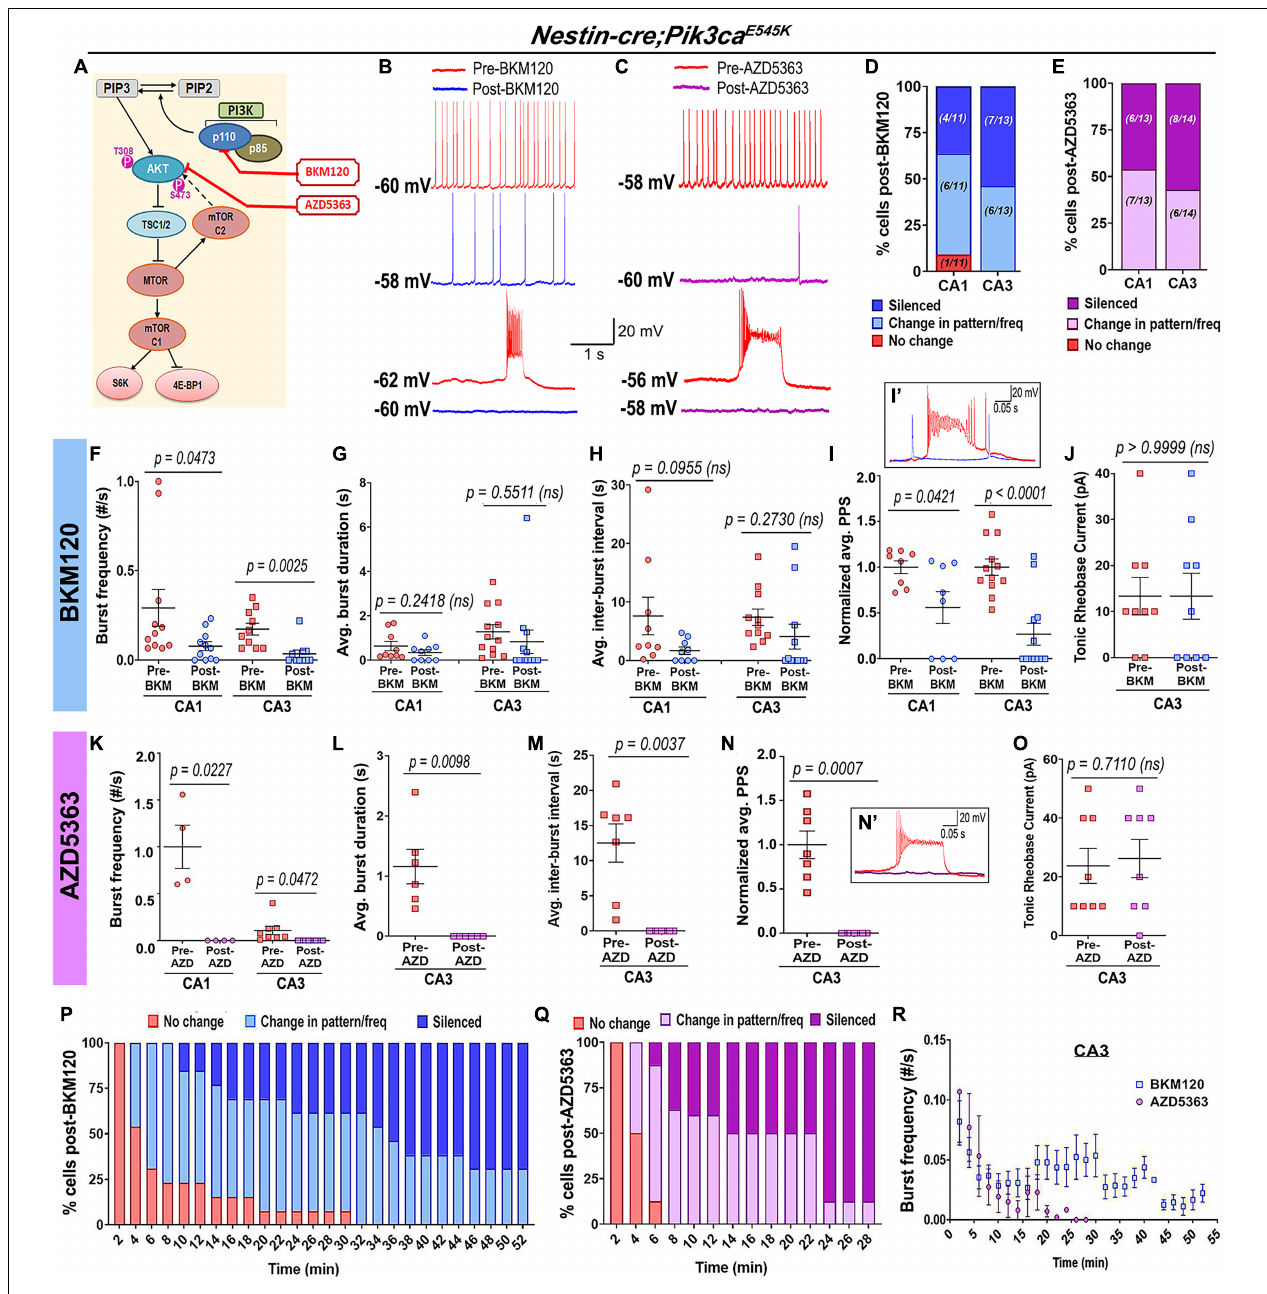
FIGURE 6 | Acute inhibition of Pik3ca or AKT suppresses hyperactivity in mutant neurons. (A) Schematic of simplified PI3K-AKT-MTOR pathway, marking targets of action for BKM120, AZD5363, and RAD001. Representative traces demonstrate differential action of BKM120 (B) and AZD5363 (C) on Nestin-cre;Pik3ca E 545 K hippocampal neurons, ranging from being unaffected to change in frequency/pattern to silencing, as quantitated, respectively, in panels (D,E) . (F–J) Acute BKM120 treatment in the mutant neurons significantly reduced burst frequency ( F = 8.937, df = 38) and PPS ( F = 24.39, df = 36) in both CA1 and CA3; but did not significantly affect the average burst duration ( t = 1.073, df = 4), inter-burst interval ( t = 0.4023, df = 4) or rheobase current ( t = 1.000, df = 4). (K–O) Acute AKT inhibition in mutant slices by AZD5363 significantly reduced burst frequency ( F = 43.50, df = 20), PPS ( t = 6.386, df = 6), average burst duration ( t = 4.052, df = 5) and inter-burst interval ( t = 4.597, df = 6), largely by suppressing bursts or silencing the cells. AZD5363 had no effect on the mutant rheobase current ( t = 0.3859, df = 7). (I’,N’) Insets show activity traces of mutant bursting cell before (red) and after BKM120 (blue) or AZD5363 (pink) administration. Plots marked percentage of mutant CA3 “bursting” cells undergoing changes as a function of time, in response to acute administration of BKM120 (P) and AZD5363 (Q) . (R) Mutant plateau frequency significantly dropped as a function of time, where 0 min marked the time of administration of BKM120/AZD5363 onto the brain slice. Data is represented as % bar graphs and mean ± SEM scatter plots; differences were considered significant at p < 0.05; ns, not significant. Each pair of pre-drug (spontaneous recording) and post-drug values (from final 5 min recording) were obtained from the same cell (F–O) . Scale bars: 1 s, 20 mV (B,C) ; 0.05 s, 20 mV (I’,N’) .